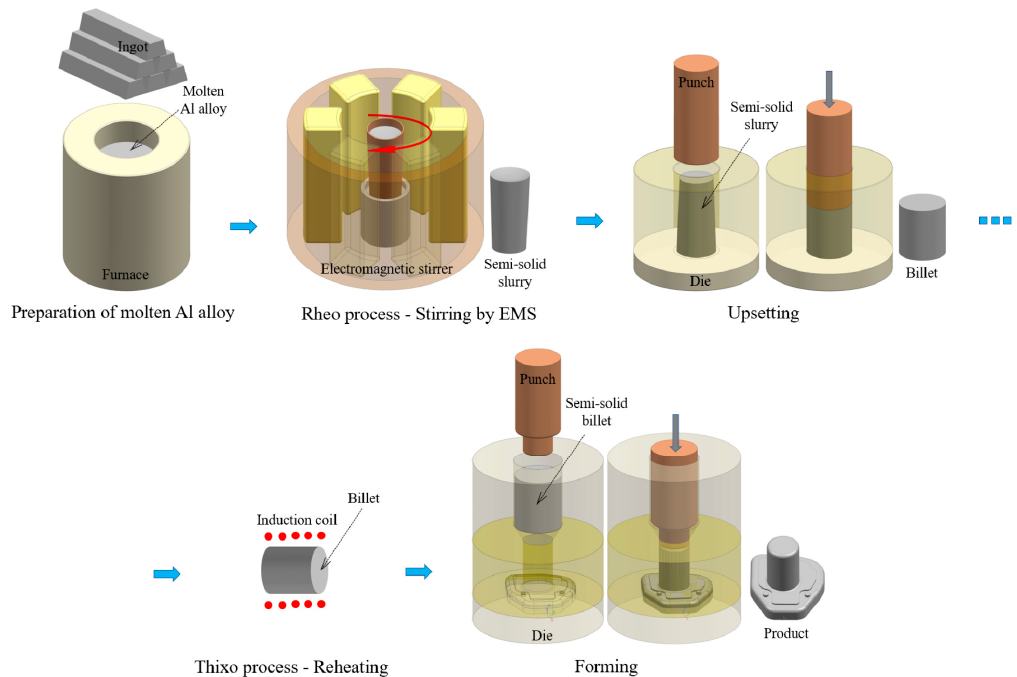
Figure 1. Manufacturing process for final sample using semi-solid billet fabricated by rheo process, upsetting and thixo processes.